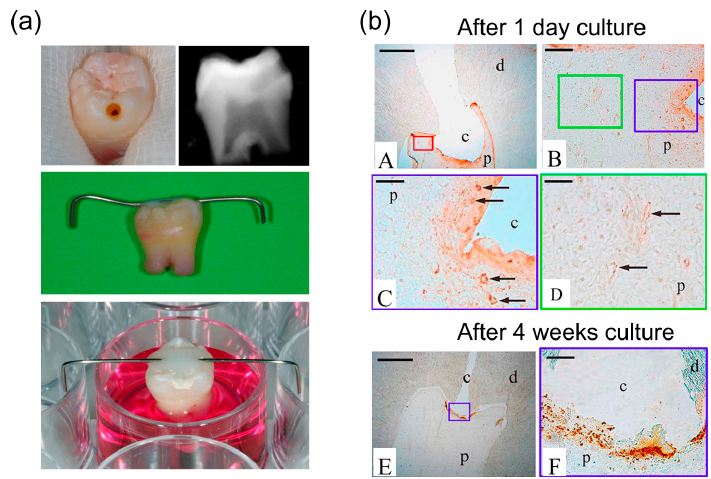
Figure 3. Overview of the ex vivo tooth model and its application for studying DPSC migration. ( a ) The pulp cavity was prepared in a clean immature third molar. X ‐ ray imaging showed that the cavity is reaching the pulp. After cavity preparation, teeth were suspended with their root canals in culture medium with the aid of a steel wire fixed on the crown; ( b ) Representative histological images of teeth cultured with medium containing 5 ‐ bromo ‐ 20 ‐ deoxyuridine (BrdU) during one day after cavity preparation, followed with medium without BrdU for four weeks. After one day, the labelling was localized in the nuclei of cells in the perivascular area. The BrdU immunolabelling exhibited a gradient. It was strong in the blood vessels surrounding the cavity ( B and C ) and decreased in those away from the cavity ( B , D ). At four weeks, the immunolabelling was localized at the cavity area only ( E and F ). Abbreviations : c: cavity; d: dentin; p: pulp; arrows indicate vessels. Scale bars in ( A , E ) 1 mm; ( B , F ) 100 μ m; ( C and D ) 50 μ m. Modified with permission from [6].